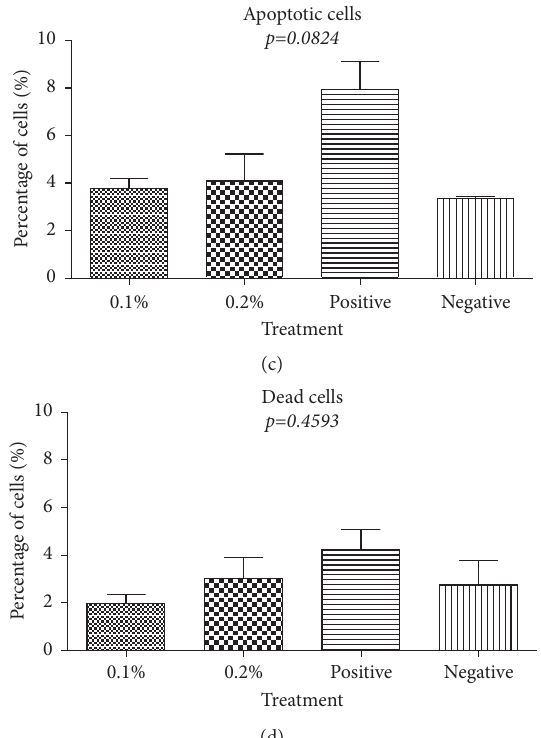
Figure 2: Annexin V-FITC apoptosis assay. (a) Confocal microscopic images of viable cells (blue- cytocalcein), apoptotic cells (green- Apopxin Green: marked with white arrows), and dead cells (red-7AAD: marked with white arrows). (b) Graphical representation of the mean (and SEM) viable, apoptotic, and dead cell proportions through immunofluorescence imaging analysis.